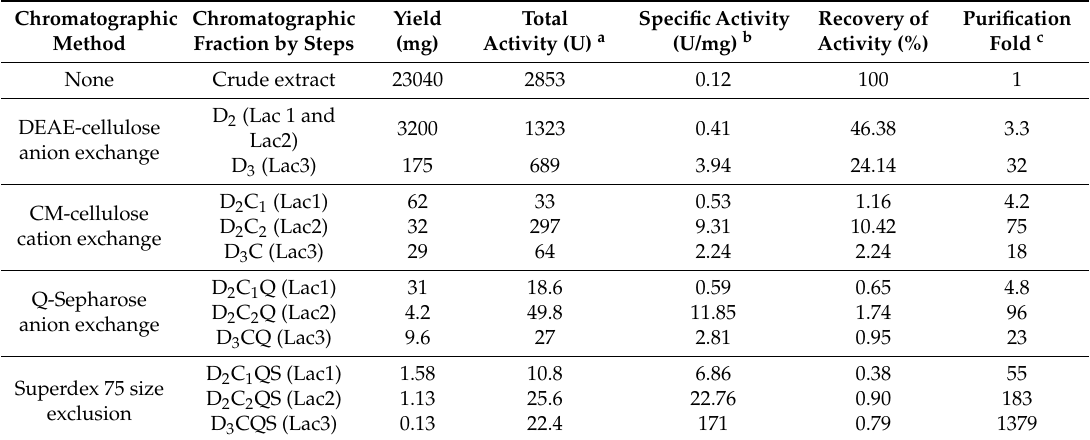
Table 1. Summary of the results obtained during the process of purification of the three laccases from P. nebrodensis .